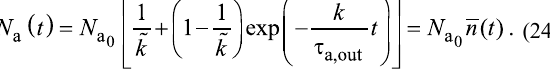
Pulsed exposure: To illustrate the use of dimensionless para- meters in FEBIP models, we consider the case of FEBIP